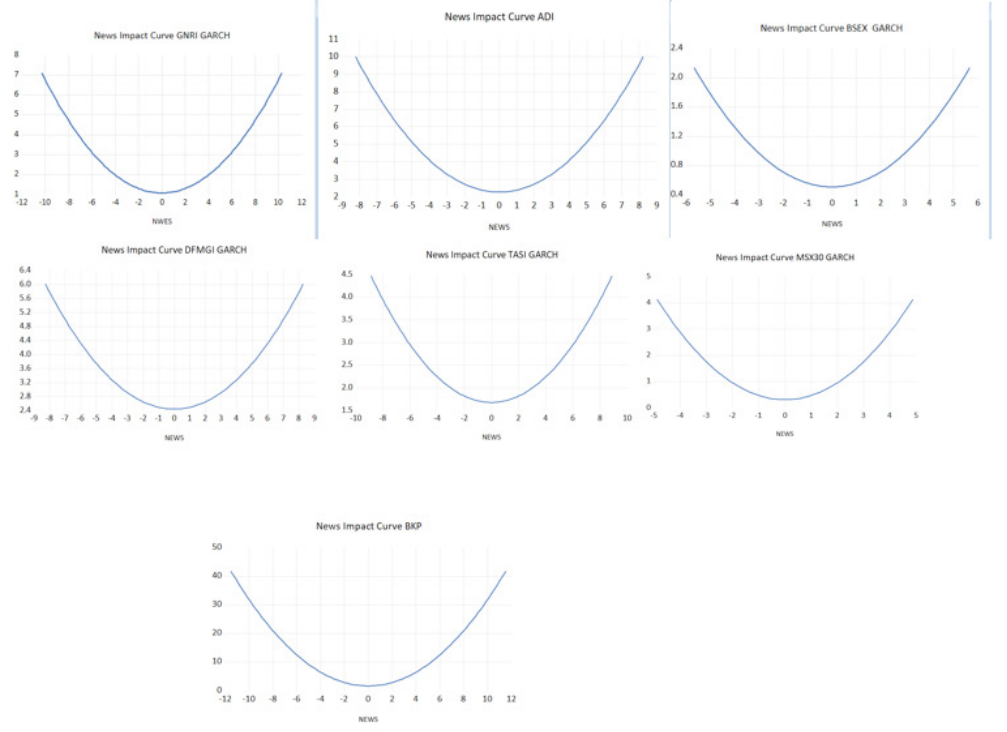
Figure 2. News impact curves of volatility models Table 7. Sign bias test